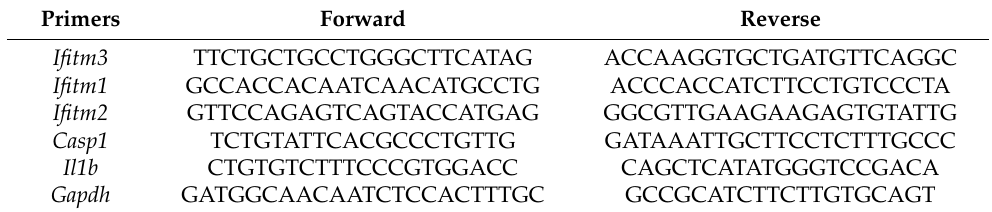
Table 1. RT-PCR Primer Sequences (5 (cid:48) to 3 (cid:48)